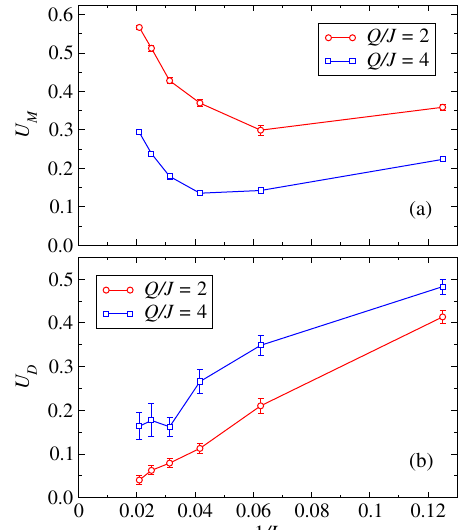
FIG. 18. Binder cumulants of the AFM (a) and VBS (b) order parameters of the site-diluted J - Q model at Q=J ¼ 2 and 4, graphed vs the inverse system size. The dilution fraction is p ¼ 1 = 32 , with exactly half of the vacancies in each